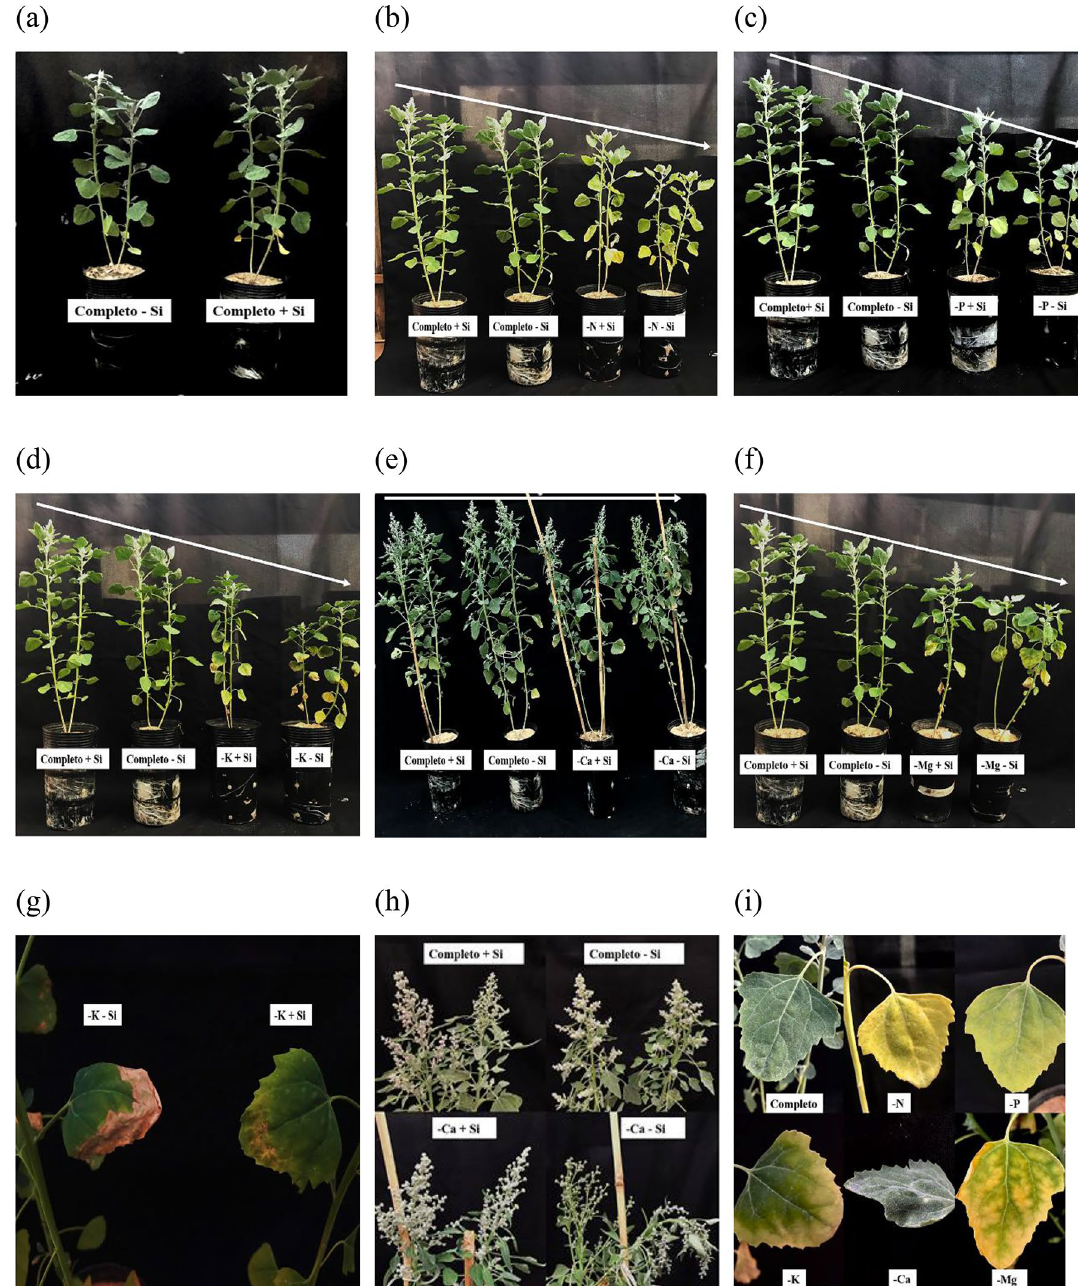
Figure 3. Symptomatology of quinoa plants submitted to Hoagland solution (Hoagland and Arnon 23 ) under omission of macronutrients in the absence and presence of Si, ( a ) complete solution, ( b ) nitrogen omission, ( c ) phosphorus omission, ( d ) potassium omission, ( e ) calcium omission, ( f ) magnesium omission, ( g ) quinoa leaves under potassium omission, ( h ) quinoa inflorescence under calcium omission, ( i ) comparison of macronutrient symptoms on quinoa leaves. Software used to create this Figure was Microsoft Word (v1804, https:// www. micro soft.